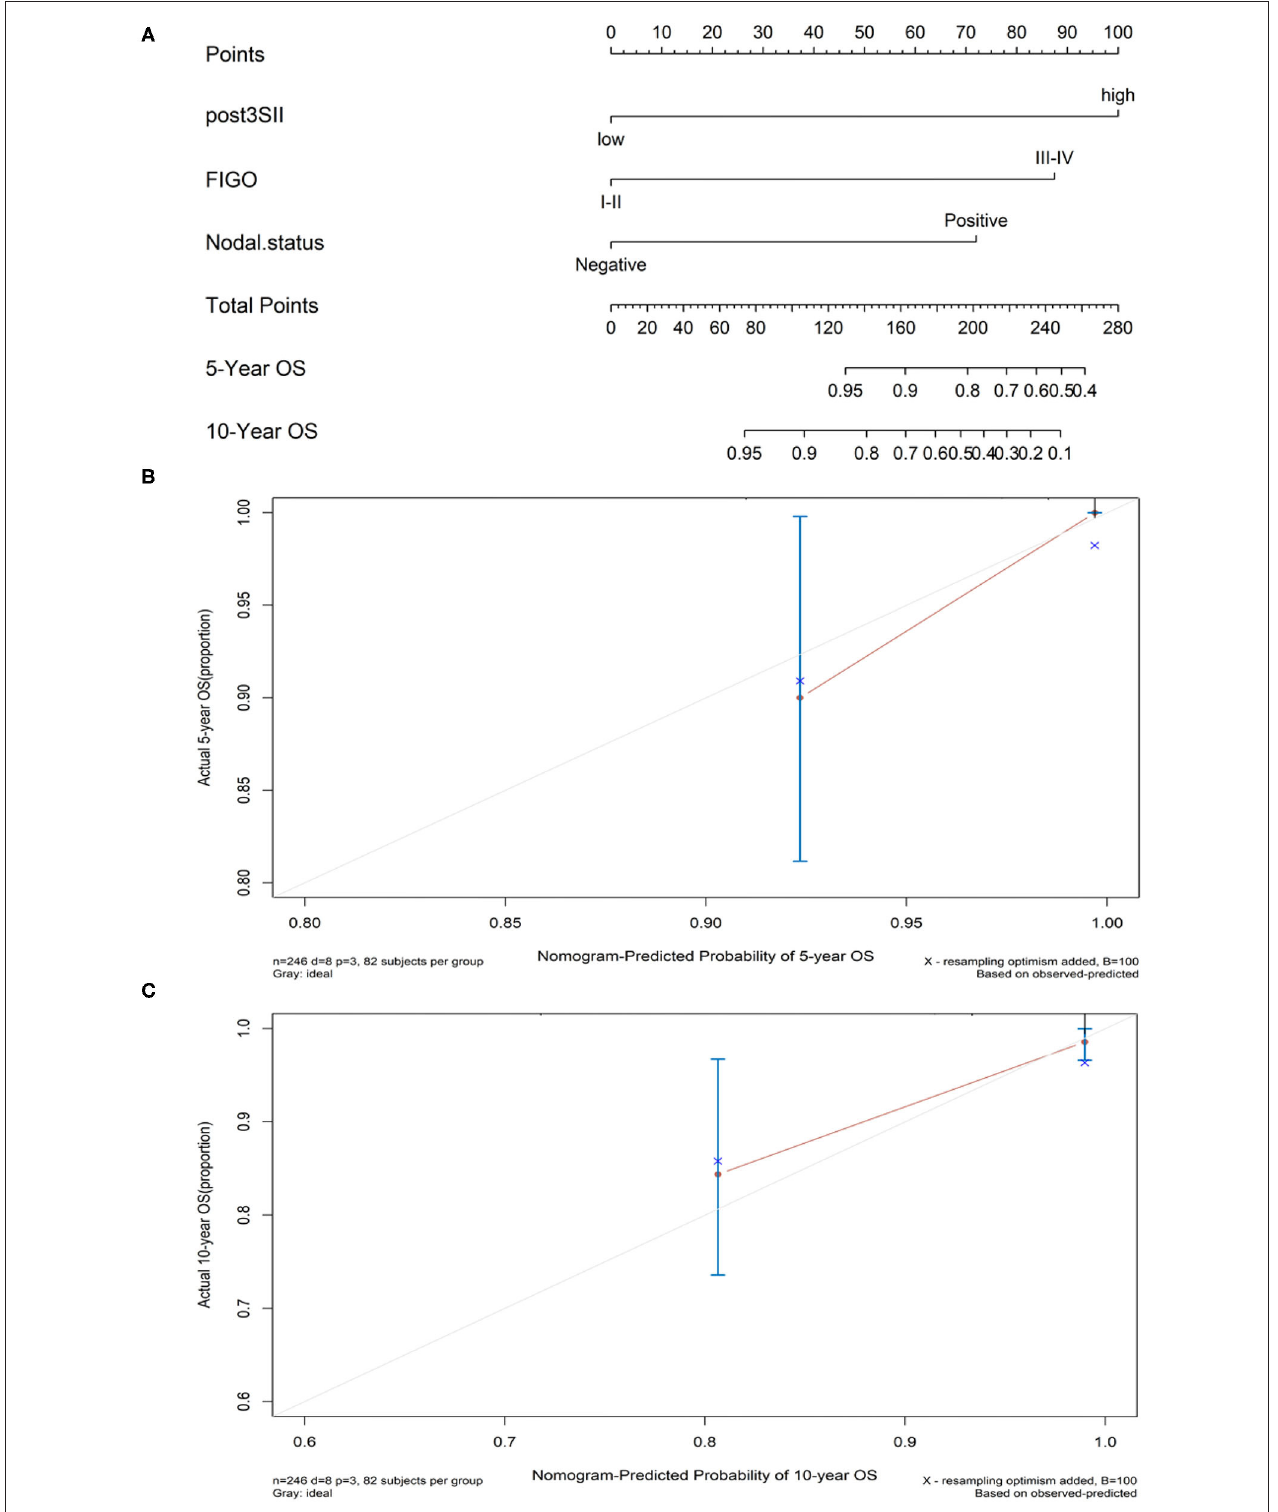
FIGURE 4 | (A) Nomogram model for estimating the rate of OS (5 or 10 years) for women with endometrial cancer. (B,C) Calibration curves of the nomograms. The calibration curves predicted OS at 5 years (B) and 10 years (C) . Nomogram-predicted probability of OS was plotted on the x -axis and the observed OS was plotted on the y